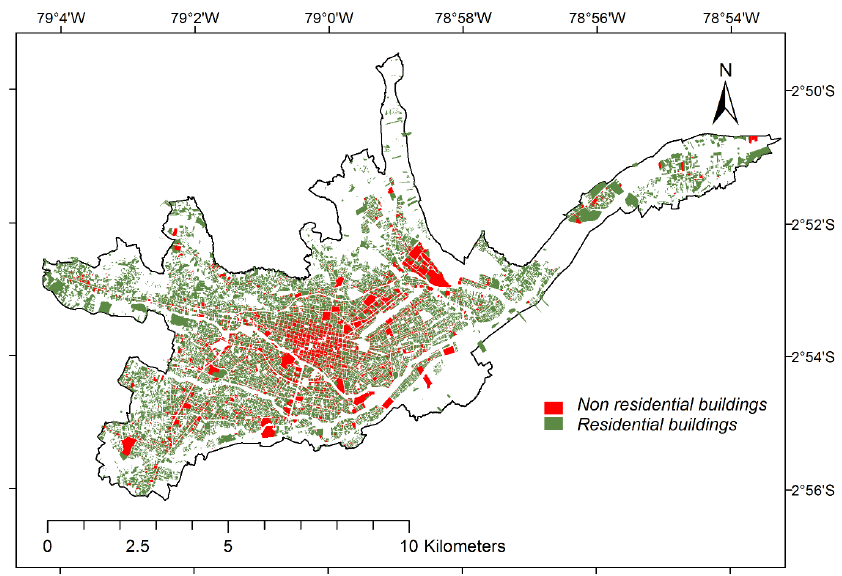
Figure 4. Cadastral building footprints of Cuenca City, classified in residential and non-residential occupancy types.